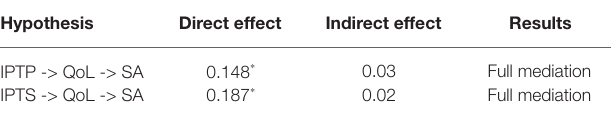
TABLE 3 | Direct and indirect effect in the tested mediation models.